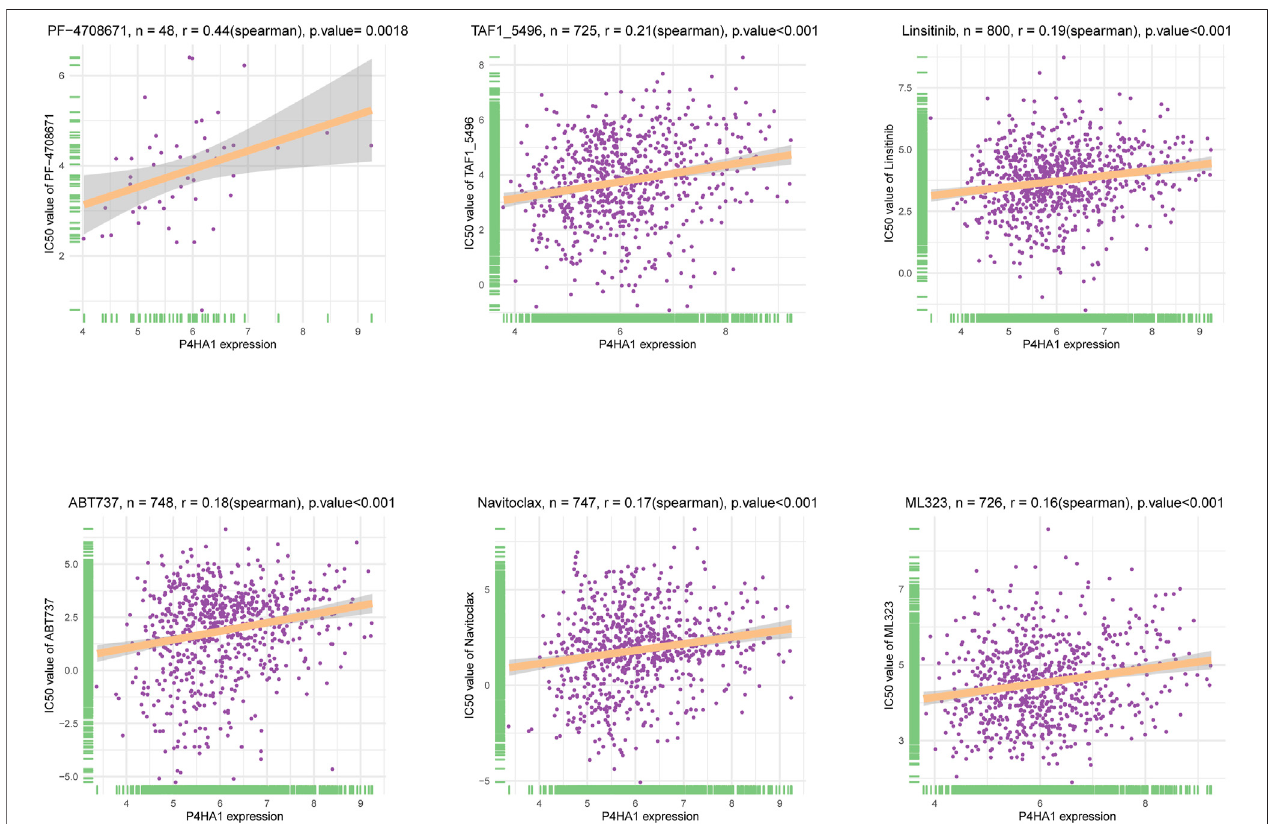
FIGURE 13 | The correlation between P4HA1 expression and IC50 values of anti-cancer drugs. The correlation between P4HA1 expression and IC50 values of indicated anti-cancer drugs.